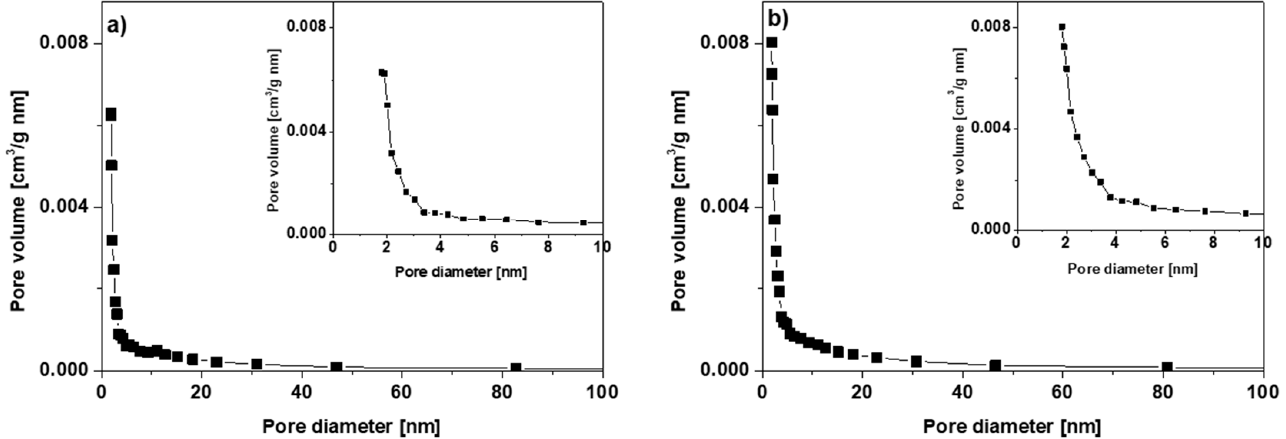
Figure 3. N 2 adsorption/desorption isotherms of ( a ) BC-CS 1-1, ( b ) BC-CS 2-1 and ( c ) BC-CS 4-1. The pore size distribution of the chitosan-modified biochars obtained from the N 2 adsorption isotherm curves is shown in Figure 4a–c, confirming the dominance of the mi- cropores in the sorbent structure. The total pore volume values decreased with the in- creasing amount of chitosan added and amounted to 0.049, 0.07 and 0.094 cm 3 /g for BC- CS 1-1, 2-1 and 4-1, respectively. The BC-CS 1-1 sample had the highest amount of chitosan added. These results may indicate that the more chitosan one adds during the synthesis, the greater the blockage of the pores and, hence, the reduction in the pore volume will be.